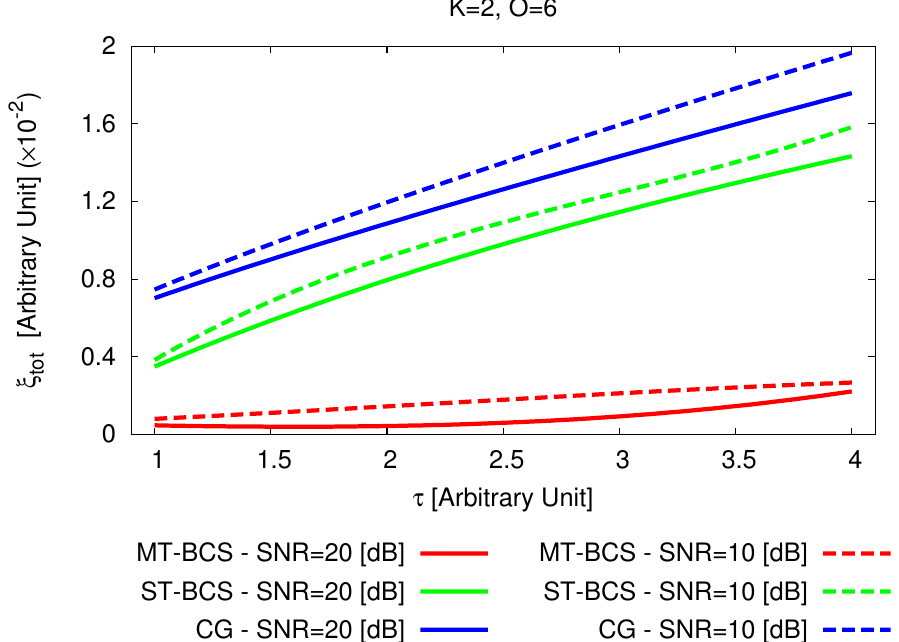
Figure 16. Comparative Assessment ( K = 2, O = 6, τ ∈ [ 1.0, 4.0 ] , SNR ∈ [ 10, 20 ] [dB])—Behavior of the total error, ξ tot , as a function of the object contrast, τ , when processing the scattering data with the MT-BCS , the ST-BCS , and the CG